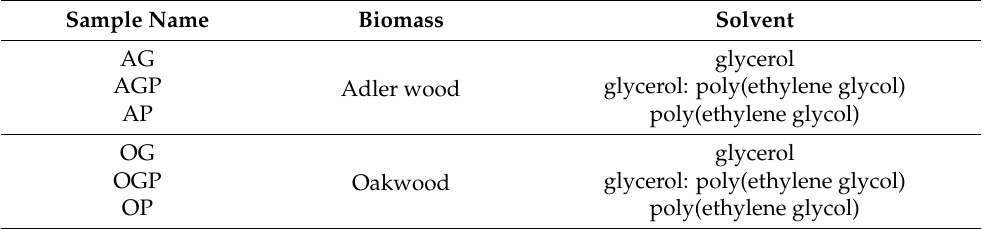
Table 1. An explanation of the abbreviations used to describe polyols samples.